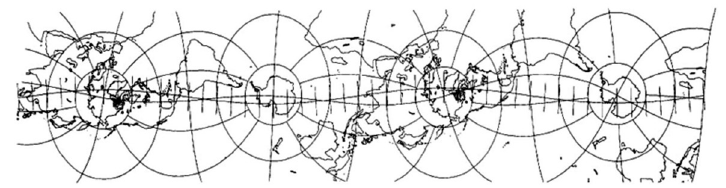
Fig. 8. Space Oblique Mercator projection (J.P. Snyder